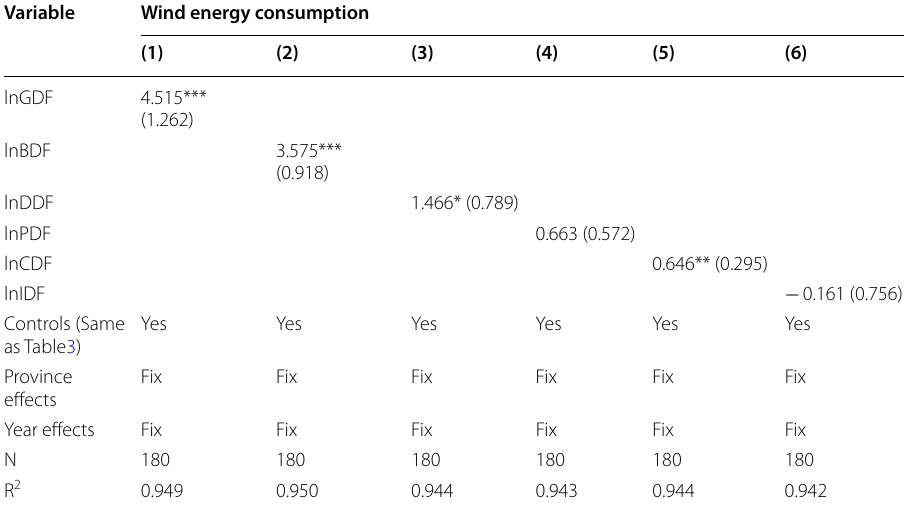
Table 5 Robustness